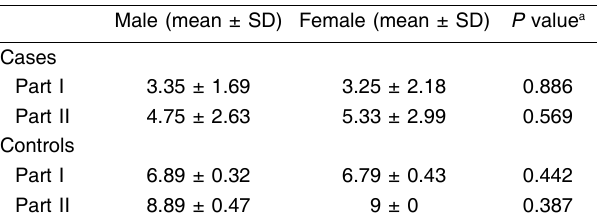
Table 5 Association between part I and part II assessment scores and